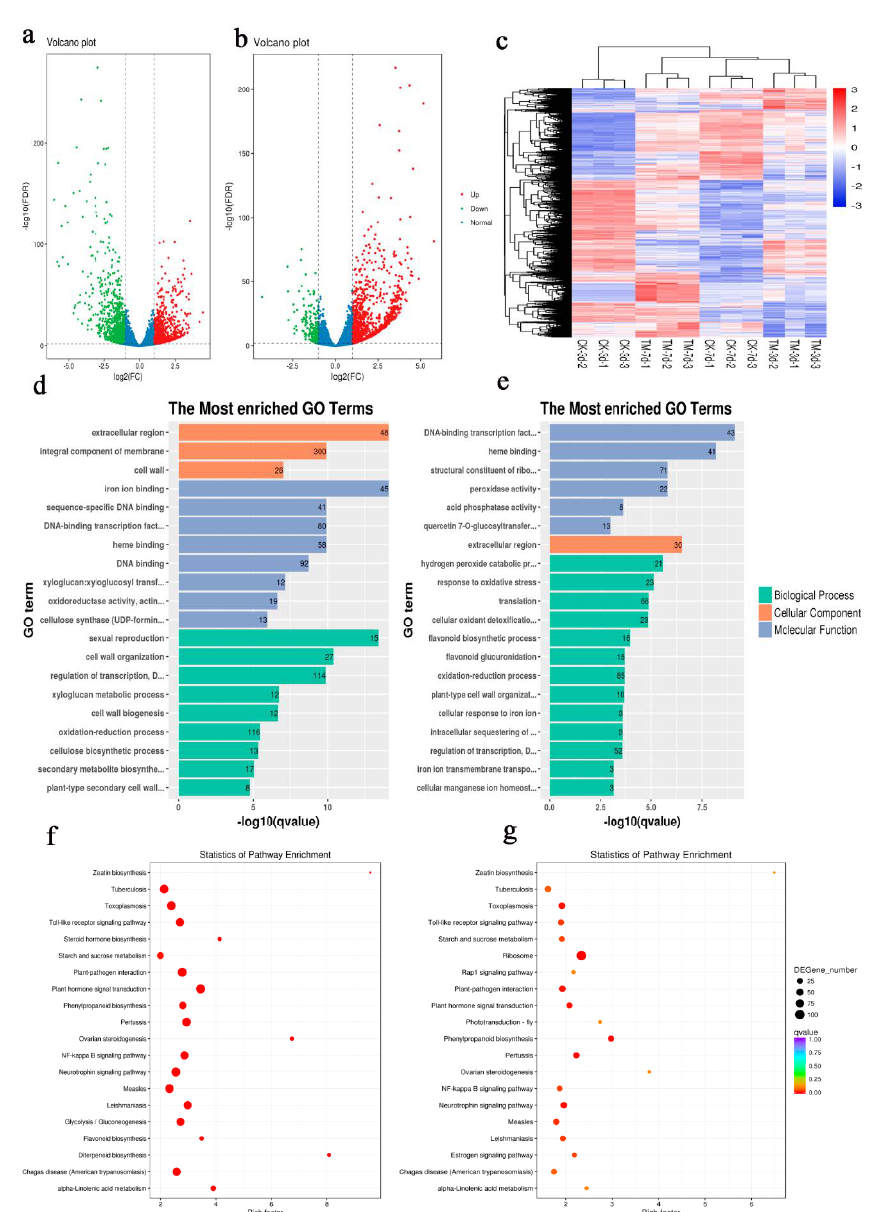
Figure 2. Statistics of di ff erentially expressed genes (DEGs) identified in di ff erent stages of sugarcane microshoot tissue treated with auxin. Enriched Gene Ontology (GO) terms and KEGG enrichment in sugarcane microshoots in response to auxin. ( a ) Volcano plot showing the upregulated and downregulated genes in TM3 compared to CK3. Each point in the volcano plot represents a gene. The green points represent downregulated genes, the red points represent upregulated genes, and the black points represent unchanged genes. ( b ) Volcano plot showing the upregulated and downregulated genes in TM3 compared to CK3. The green points represent downregulated genes, the red points represent upregulated genes, and the black points represent unchanged genes. ( c ) Hierarchical cluster analysis. Di ff erent columns in the figure represent di ff erent samples, and di ff erent rows represent di ff erent genes. The colors from blue to yellow indicate increasing gene expression levels. ( d , e ) Significantly enriched GO terms ( p < 0.05) in CK3 vs. TM3 and in CK7 vs. TM7. GO terms belonging to biological process, cellular component, and molecular function are shown in green, orange, and blue, respectively. ( f , g ) Top 20 pathways of DEGs in CK3 vs. TM3 and in CK7 vs.